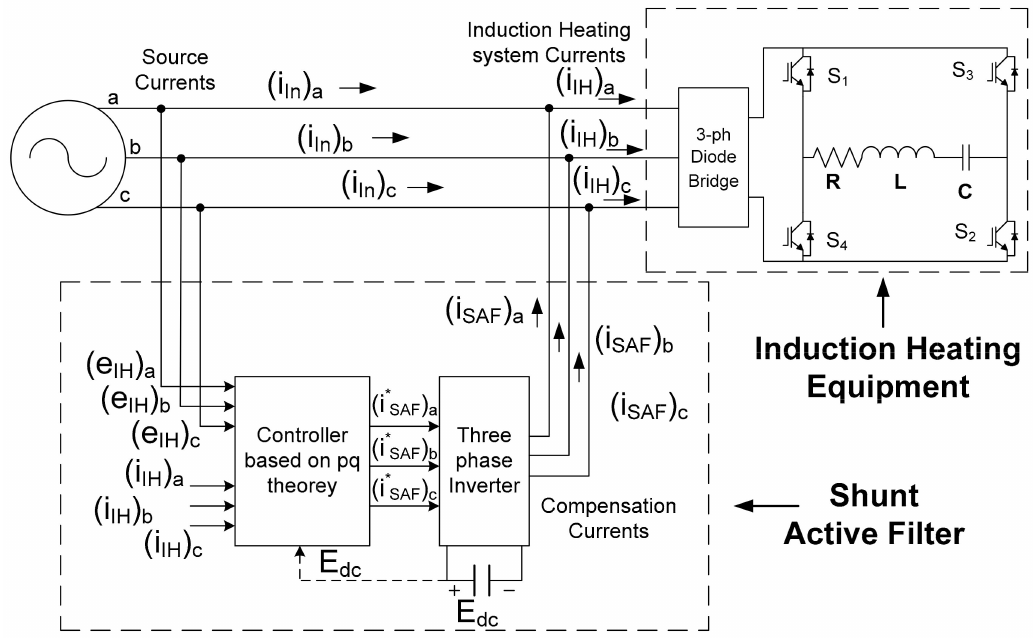
Figure 1. Proposed design of a shunt active filter for induction heating